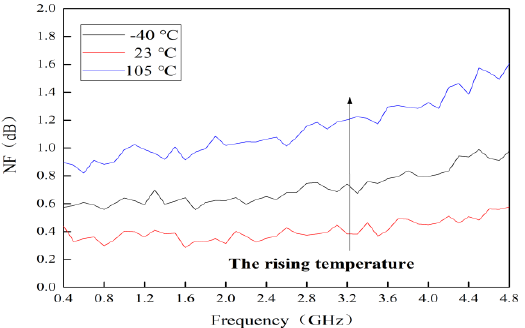
Figure 12. Measured curves of NF at different temperatures.